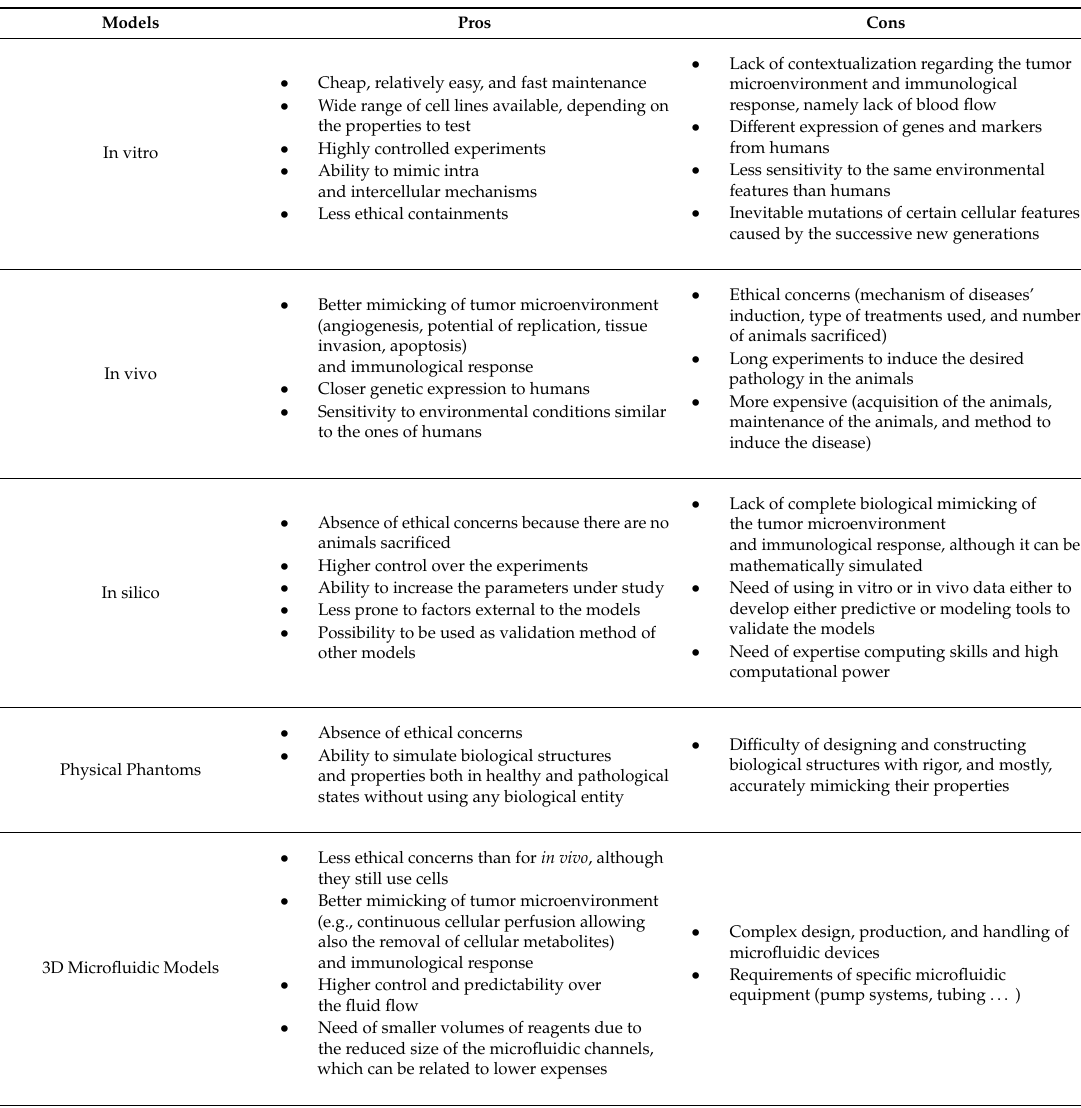
Table 5. Summary table exposing the main advantages and disadvantages identified by the authors for each breast cancer model mentioned in this review